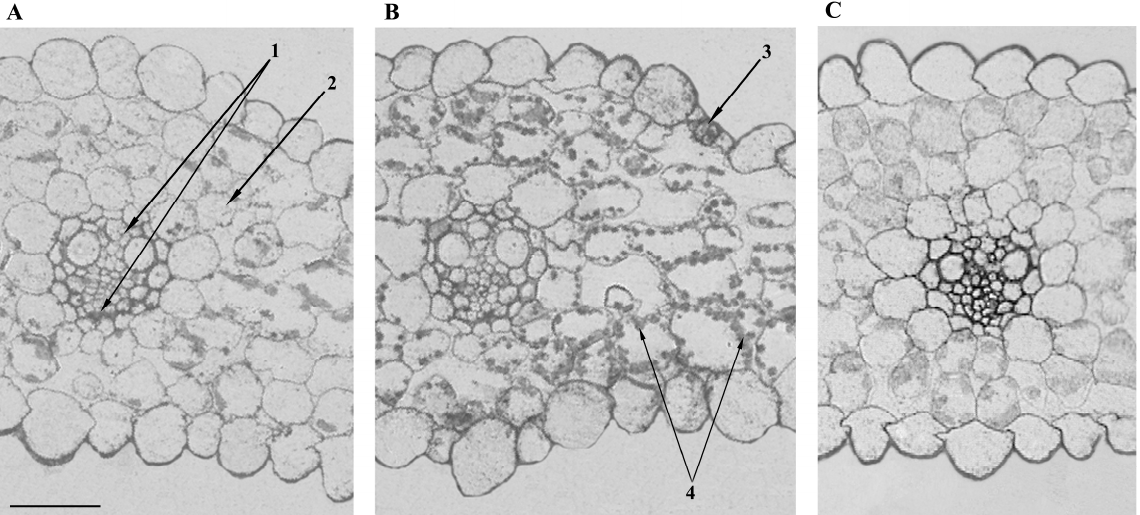
Figure 4. Immunohistochemical localization of ABA in the leaves of the control ( A ), salt- ( B ), and ABA-treated ( C ) barley plants. 1—vasculature, 2—mesophyll, 3—stomata, 4—chlorophyll. Scale 100 µm.